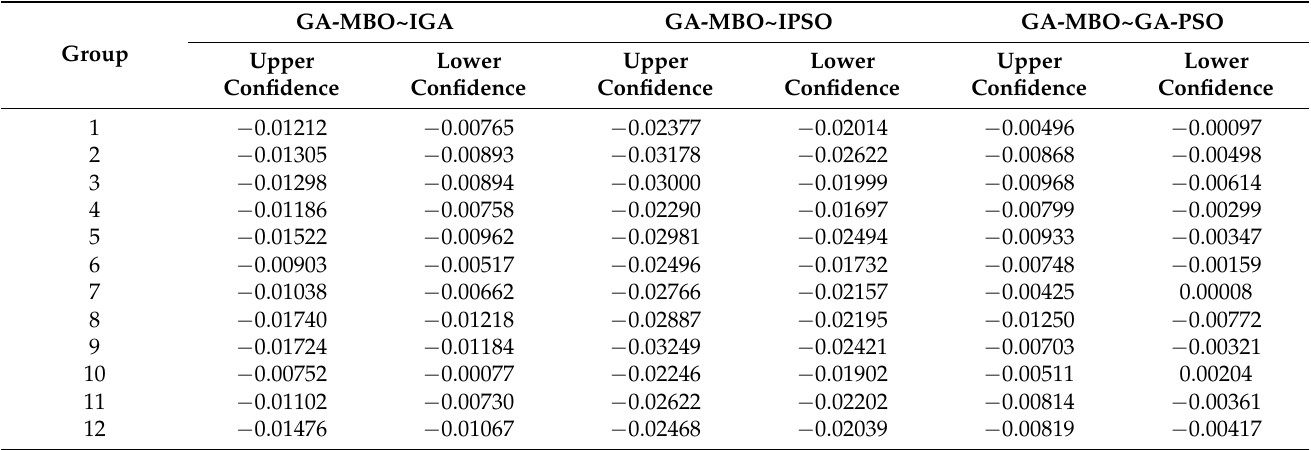
Table 8. T-test of optimal solution between GA-MBO and other algorithms with confidence of